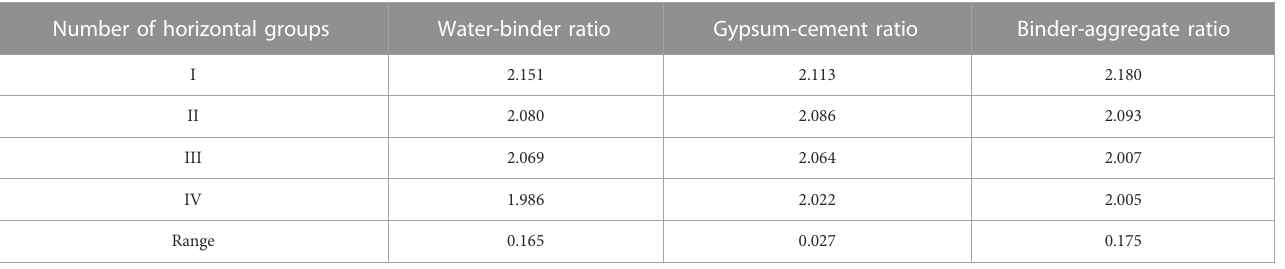
TABLE 4 Density range analysis (g.cm − 3 ).